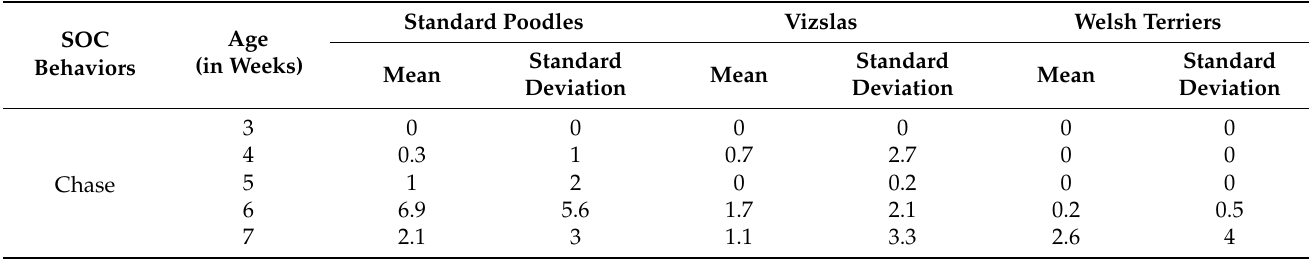
Table A3. Individual behaviors in the SOC play context for each breed. Mean and standard deviation of duration data for individual behaviors in the (social/SOC) group at 3–7 weeks of